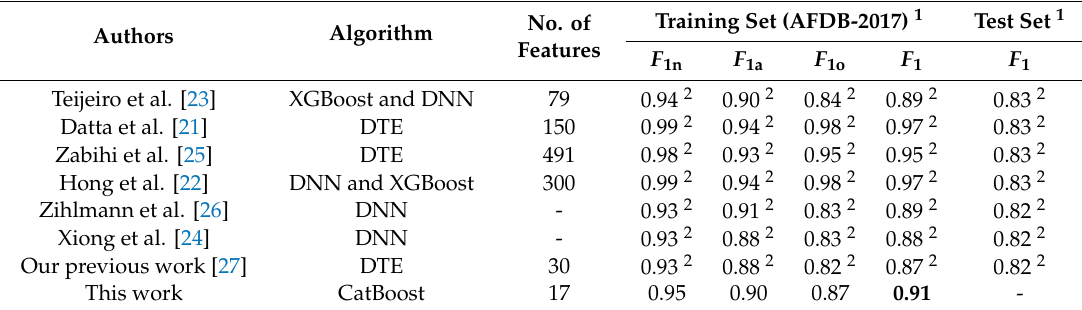
Table 7. Performance comparison of AF classifiers on the Challenge